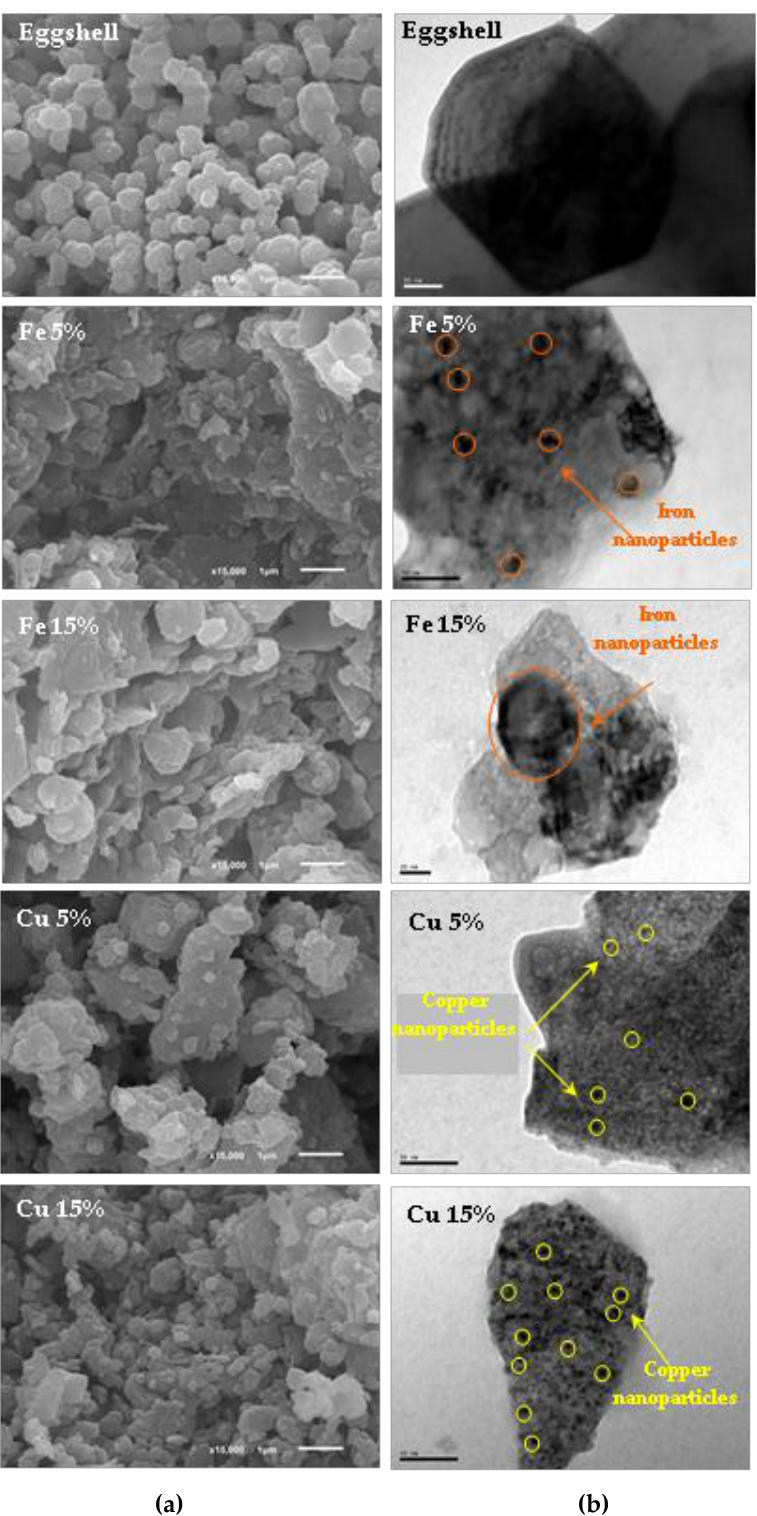
Figure 3. ( a ) SEM images and ( b ) TEM images of the calcined eggshell and the iron and copper supported